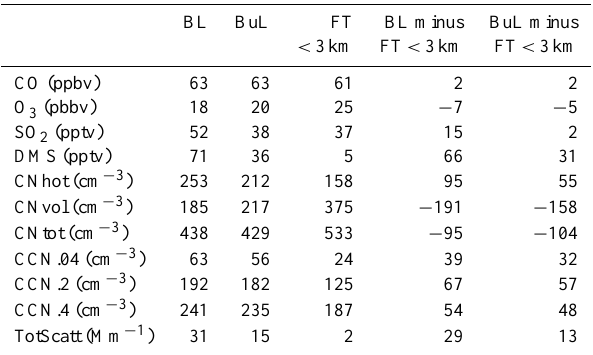
Table 1. Mean concentrations of key parameters in lower BL, BuL and FT <